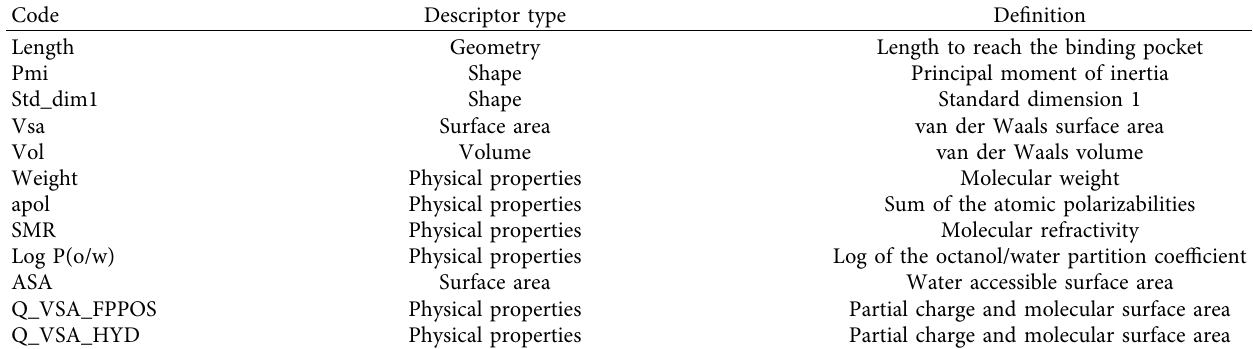
Table 1: Symbols, types, and definitions of selected